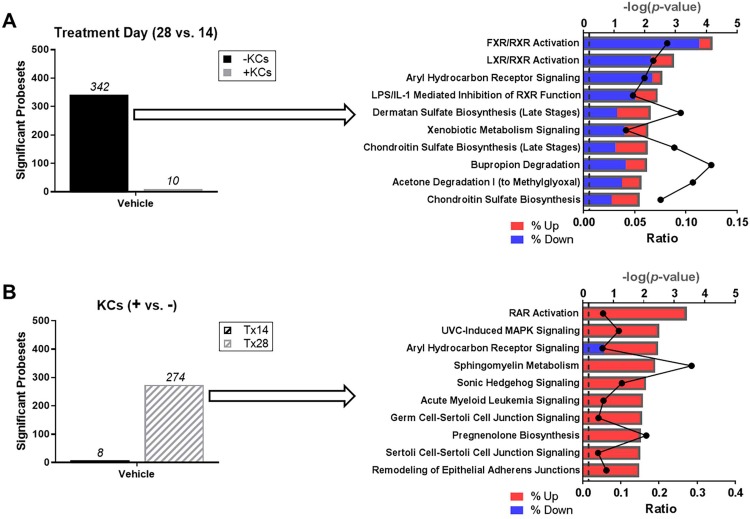
Impact of time and Kupffer cells on baseline tissue gene expression profiles.(A) Number of differentially expressed genes that vary over time in the standard and modified tissue model treated with vehicle. Enriched pathways from the list of 342 differentially expressed genes observed in the standard tissue model. (B) Number of differentially expressed genes that vary with the incorporation of Kupffer cells in vehicle-treated tissues at treatment day 14 and 28. Enriched pathways from the list of 274 differentially expressed genes observed at treatment day 28. Data represent the -log(P-value) for pathway significance (bars) and the ratio (black line) of the number of genes from the dataset divided by the total number of genes comprising a pathway from the IPA knowledge base. The shading within each bar represents the proportion of down- (blue) versus up-regulated (red) genes within a particular pathway. Abbreviations: FXR, farnesoid X receptor; LPS, lipopolysaccharide; LXR, liver X receptor; MAPK, mitogen activated protein kinase; RAR, retinoid acid receptor; RXR, retinoid X receptor; UVC, ultraviolet C.